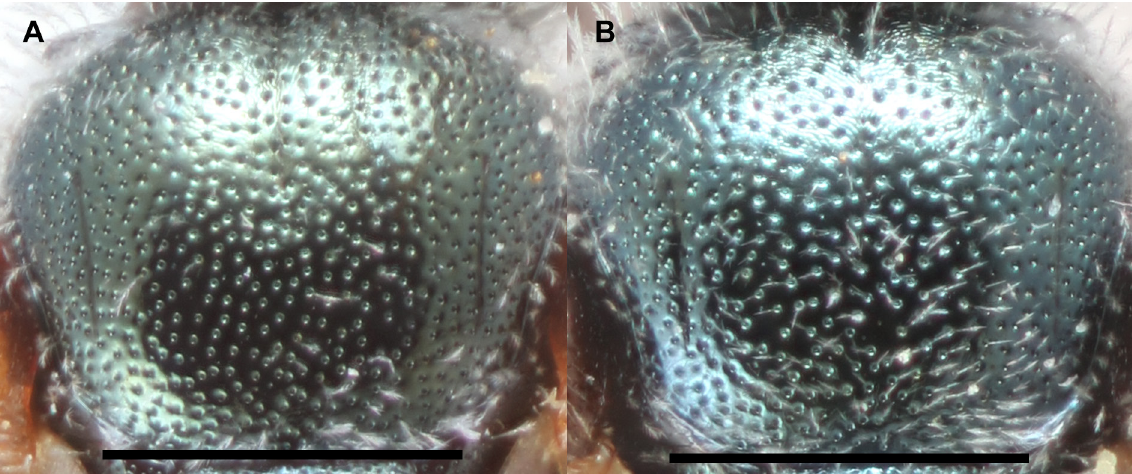
Fig. 120. Mesoscutum. A . Lasioglossum ellisiae (Sandhouse, 1924), ♂, evenly punctate with most IS = 1 PD. B . L. diabolicum sp. nov., ♂, more coarsely and unevenly punctate. Scale bars = 0.5